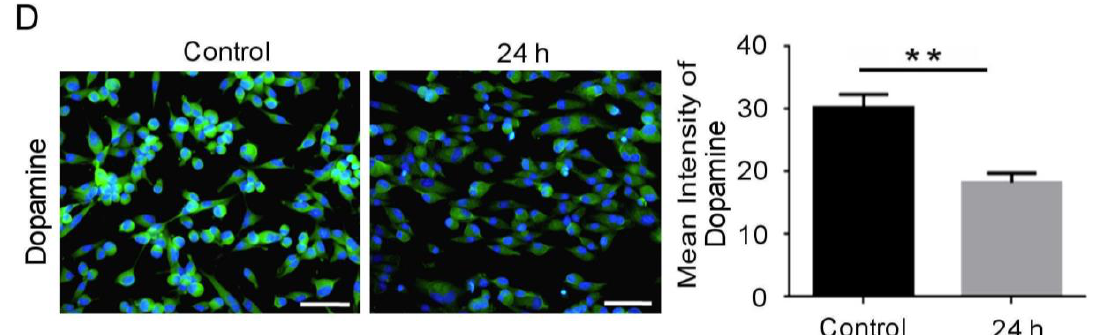
Figure 1. Mechanical injury induces neuron injury through stretching. ( A ) SH-SY5Y neuroblastoma cells are stretched in the uniaxial direction; cell alignment was measured by an angle deviation of 30° in plane, with both ends of each cell. Cell alignment after 6 h was measured using ImageJ. ( B ) The cells were stained with JC-1 probe immediately after 6 h of stretching. The JC-1 probe detects changes in the mitochondrial potential. It was analyzed by flow cytometry for 6 h after stretching. The mechanical stimulation altered the mitochondrial membrane potential. ( C ) A set of representative anti-8-OHdG immunofluorescent stained images (green) depicts an increase in 8-OHdG fluorescence signal at 24 h of stretching, compared to the control. ( D ) A set of representative anti-Dopamine immunofluorescent stained images (green) depicts a decrease in dopamine fluorescence signal at 24 h of stretching, compared to the control. Blue color 4’,6-diamidino-2-phenylindole denotes nuclei. Blue color 4’,6-diamidino-2-phenylindole denotes nuclei. Data are presented as mean ± SD. Scale bar = 50 μm; ** p < 0.01. 8-OHdG, anti-8-hydroxy-2-deoxyguanosine.